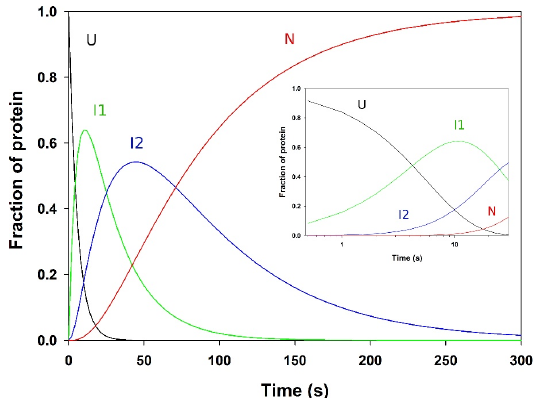
Figure 9. Simulation of the time-course of the fractional population of the various species for a four-state sequential model with two on-pathway intermediates (Scheme (5)). The simulation was performed using a program developed with the MATLAB computing platform (MathWorks Inc., Natick, MA, USA), with λ 1 = 0.1754 s − 1 (i.e., τ 1 = 5.7 s), λ 2 = 0.0412 s − 1 (i.e., τ 2 = 24 s) and λ 3 = 0.0159 s − 1 (i.e., τ 3 = 63 s). The inset shows the first 30 s of the simulated kinetics, on a logarithmic time scale.